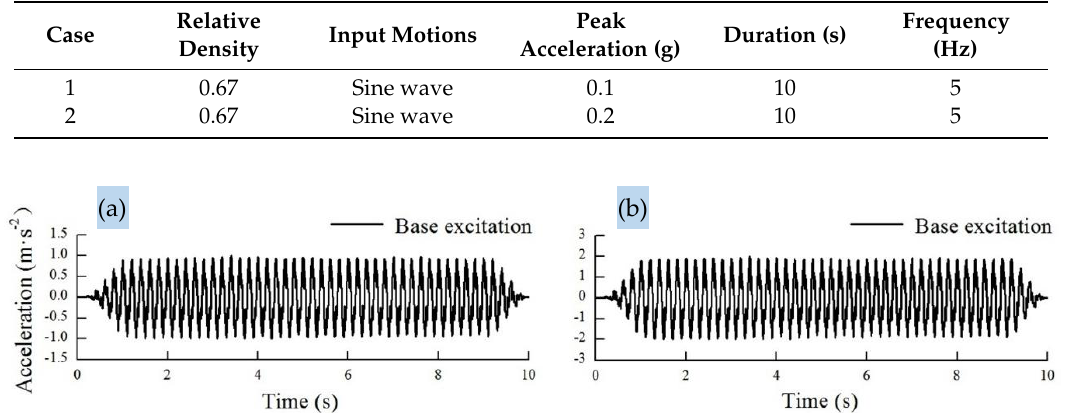
Figure 5. Time history curves of base excitation: ( a ) 0.1 g; and, ( b ) 0.2 g.